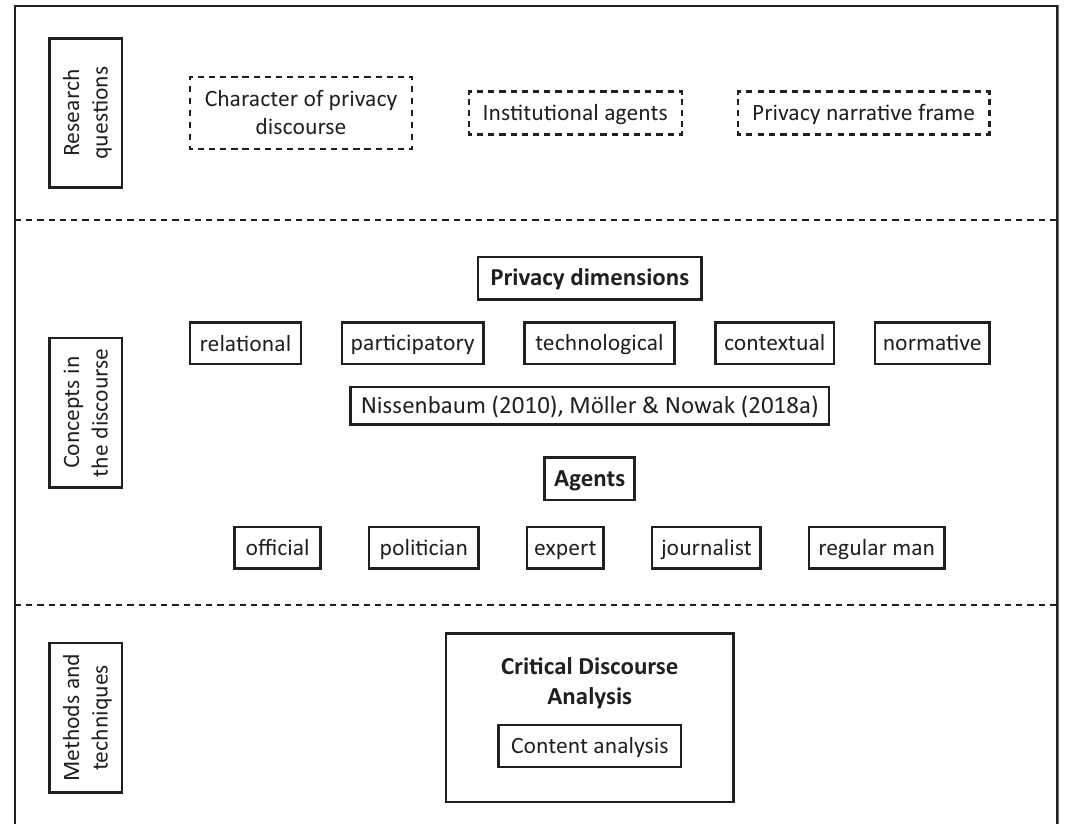
Figure 1. Analytical